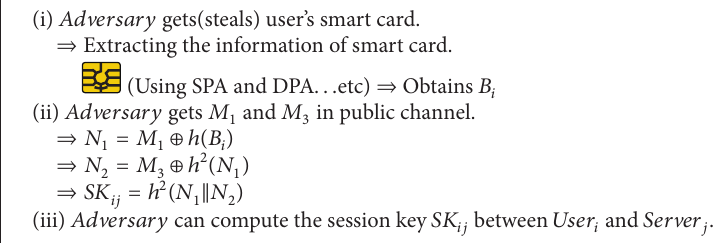
Algorithm 2: Smart card attack on Chuang and Chen’s scheme.